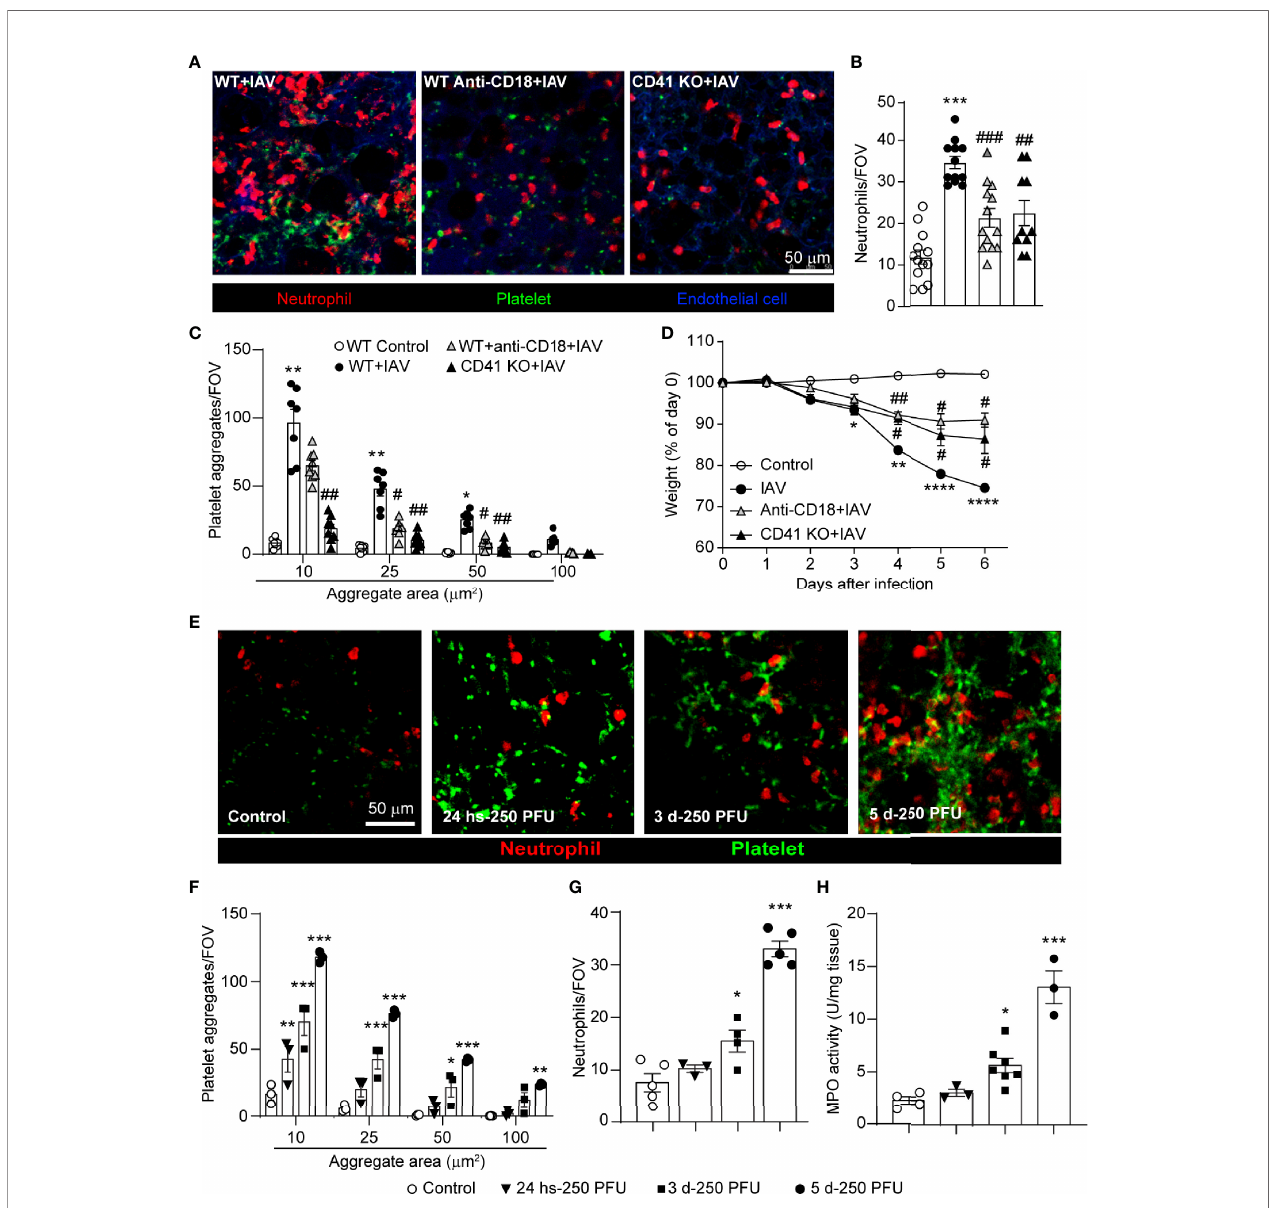
FIGURE 2 | Dynamics of Virus-Induced Neutrophil Recruitment and Platelet Accumulation in the Lungs. (A) Intravital visualization of neutrophils and platelet aggregation in the lung vasculature 5d-post IAV-infection in animals with anti-CD18 blocking antibody (WT Anti-CD18+IAV) or CD41 de fi ciency (CD41 KO+IAV) (neutrophils, red; platelets, green; endothelium, blue). Quanti fi cation of neutrophils (B) and platelets (C) within the lung as measured by IVM. Values are the mean number of neutrophils per fi eld of view (FOV) ± SEM, n=3-5 per group. (D) Animal weight measurements following infection with or without integrin blockade/ de fi ciency. Values are shown as the mean of weights normalized to day 0 ± SEM, n=3-5 per group. (E) IVM of neutrophil recruitment and platelet aggregation in control, 24h-post IAV infection and 3d and 5d-post IAV infection (neutrophils, red; platelets, green). (F) Quanti fi cation of platelet aggregates of indicated sizes (F) and neutrophils (G) at indicated times post IAV infection. (H) MPO activity at indicated times post IAV infection. Values are the mean number of aggregates per fi eld of view (FOV) ± SEM, n=3-5 per group. *p < 0.05, **p < 0.01, ***p < 0.001 ****p < 0.0001 compared to the control group; # p < 0.05, ## p < 0.01, ### p < 0.001 compared to the IAV-infected